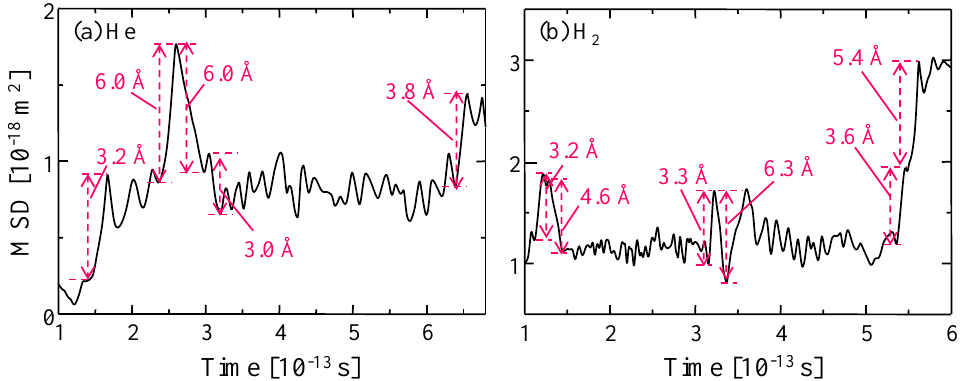
Figure 11. MSD curve of ( a ) one helium and ( b ) one hydrogen molecule obtained from their trajectories as a function of time. The numerical value in the figure indicates a jumping distance directly calculated from their positions at each point in time.